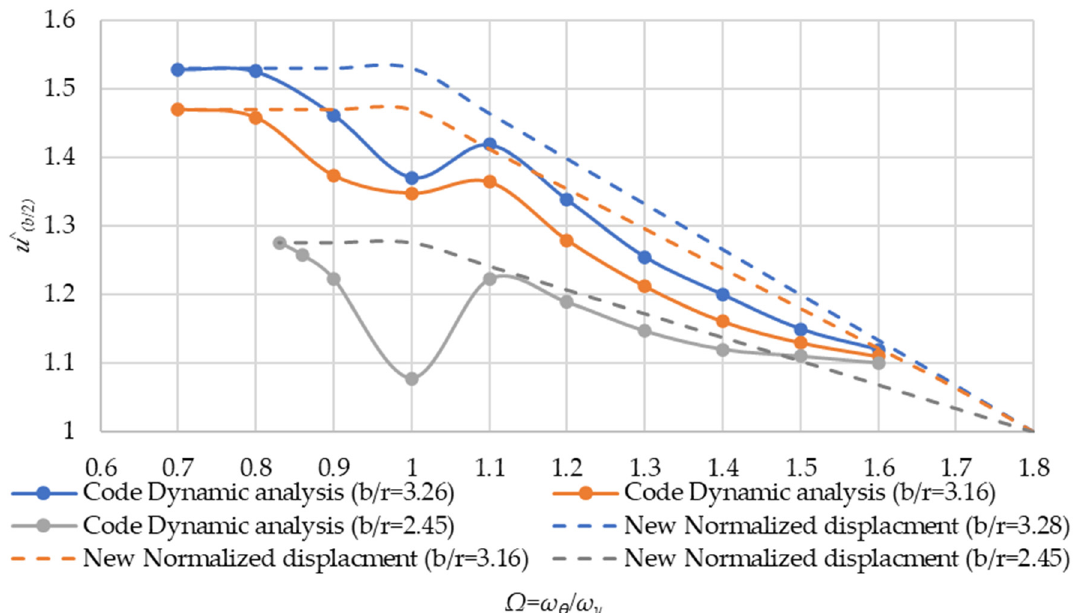
Figure 17. De la Llera Juan C. and Chopra Anil K., [6] proposed method and dynamic analysis normalized edge displacement.